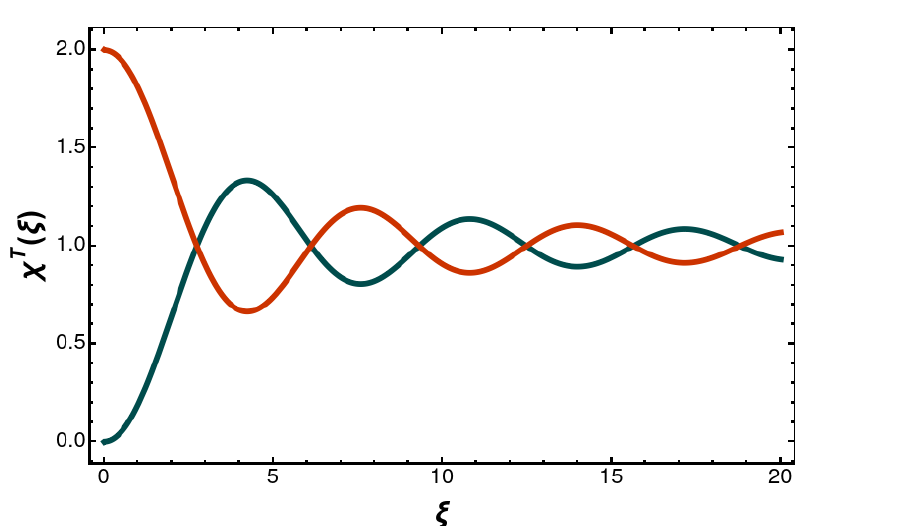
( ξ ) , which is the ratio of the effective decay rate f Figure 3. The plot shows the function χ T ( ξ ) = 1 ± ⊥ of the superradiant and subradiant entangled Dicke states as a function of the interatomic distance. The red curve corresponds to the positive sign (superradiant), and the blue curve corresponds to the negative sign (subradiant state). The decay rate of the transverse superradiant state, in the short-range limit, assumes a value equal to twice the natural decay rate.